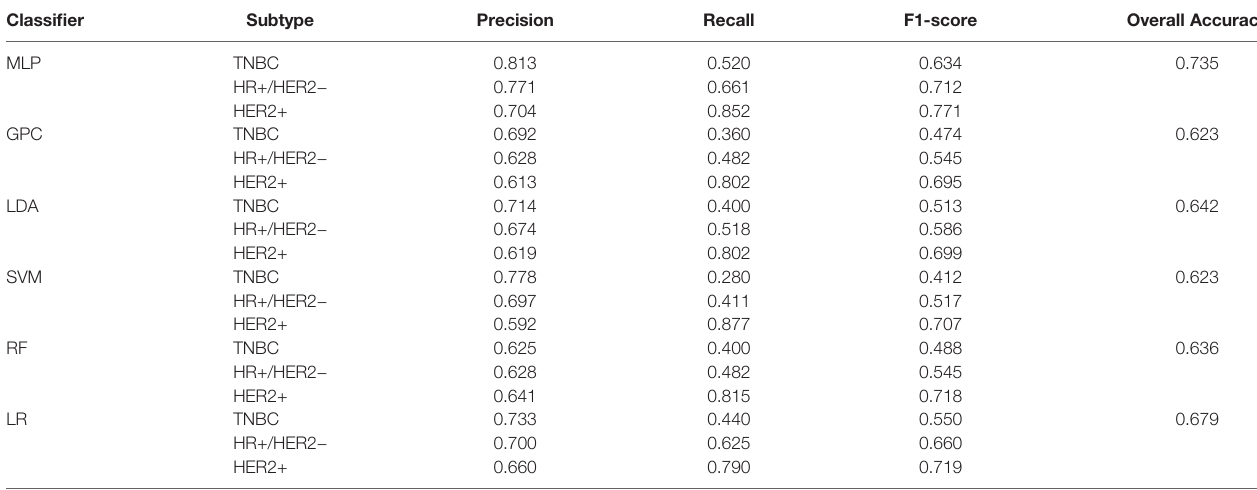
TABLE 5 | Performances of the six machine learning classi fi ers for predicting molecular